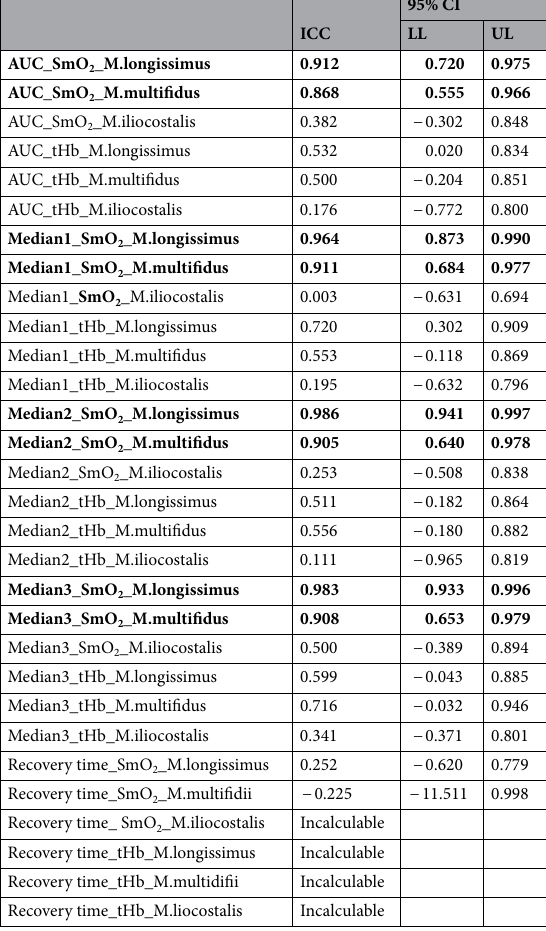
Table 1. Test–retest reliability for area under the curve (AUC), Median 1, Median 2, Median 3 for oxygen saturation (SmO 2 ) perfusion (tHb) and recovery time of M. longissimus , M. multifidus and M. iliocostalis . Recovery time for SmO (ICC), the 95% confidence intervals (95% CI), lower level (LL) and upper level (UL). Excellent reliability is highlighted in bold. Based on these results, only the measures for muscle oxygenation (SmO 2 ) in the M. longissimus and M. multifidus were analysed in the main study.